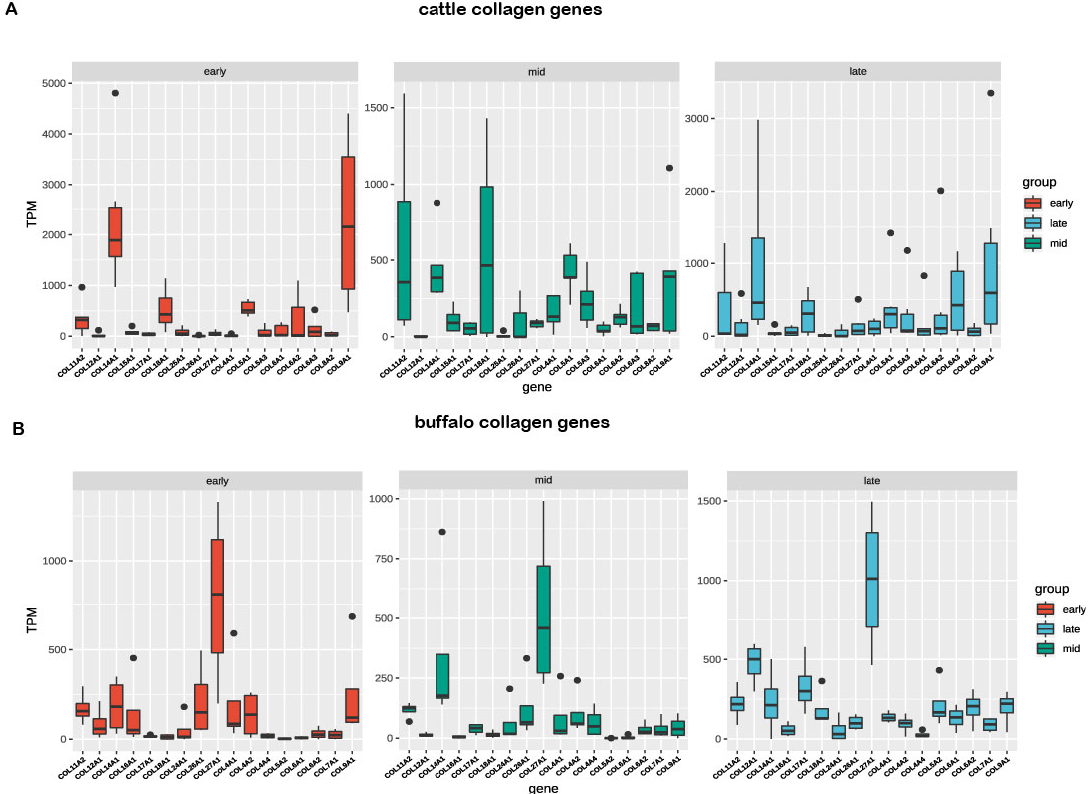
Figure 4. Collagen expression analysis of cattle ( A ) and buffalo ( B ) in milk at different lactations. Red box indicates early lactation; green box indicates mid-lactation; light blue box indicates late lactation.